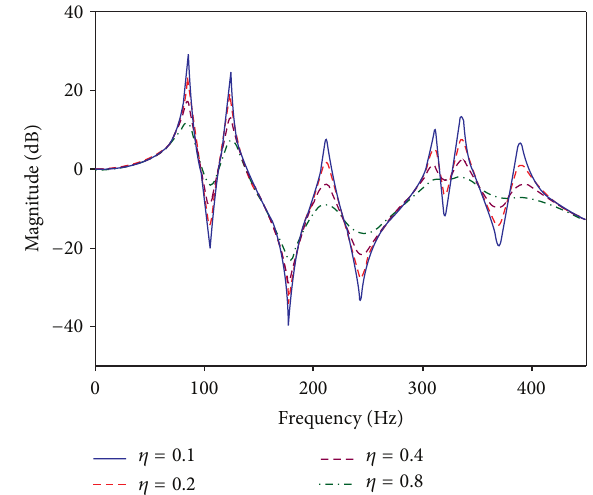
Figure 2: Frequency response functions of fiber reinforced cylindri- cal composite panel with variation of damping ratio 𝜂 of viscoelastic layer.